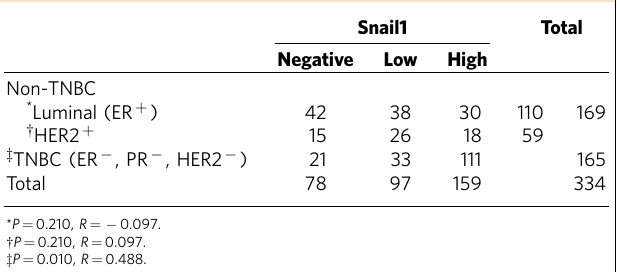
Table 3 | Co-expression of Dub3 and Snail1 in different subtypes of breast cancer